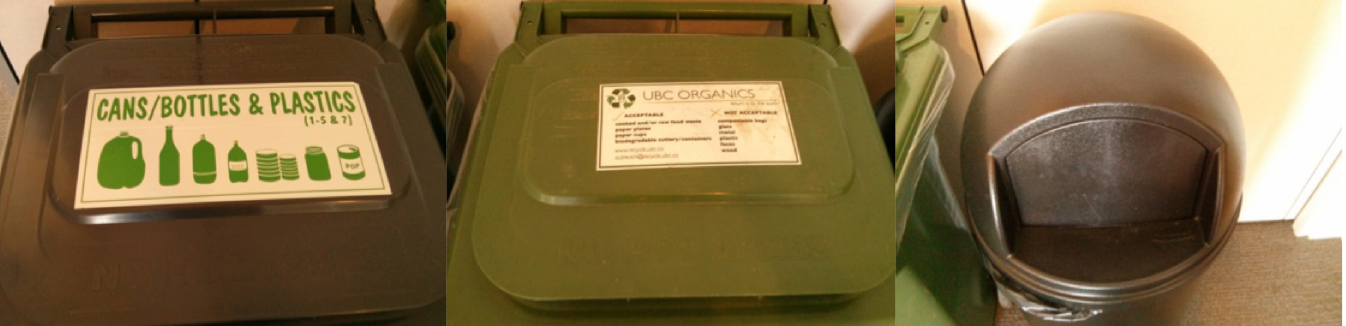
Fig 2. The three categories of receptacles made available to the participants. From left to right: containers, organics, and garbage.